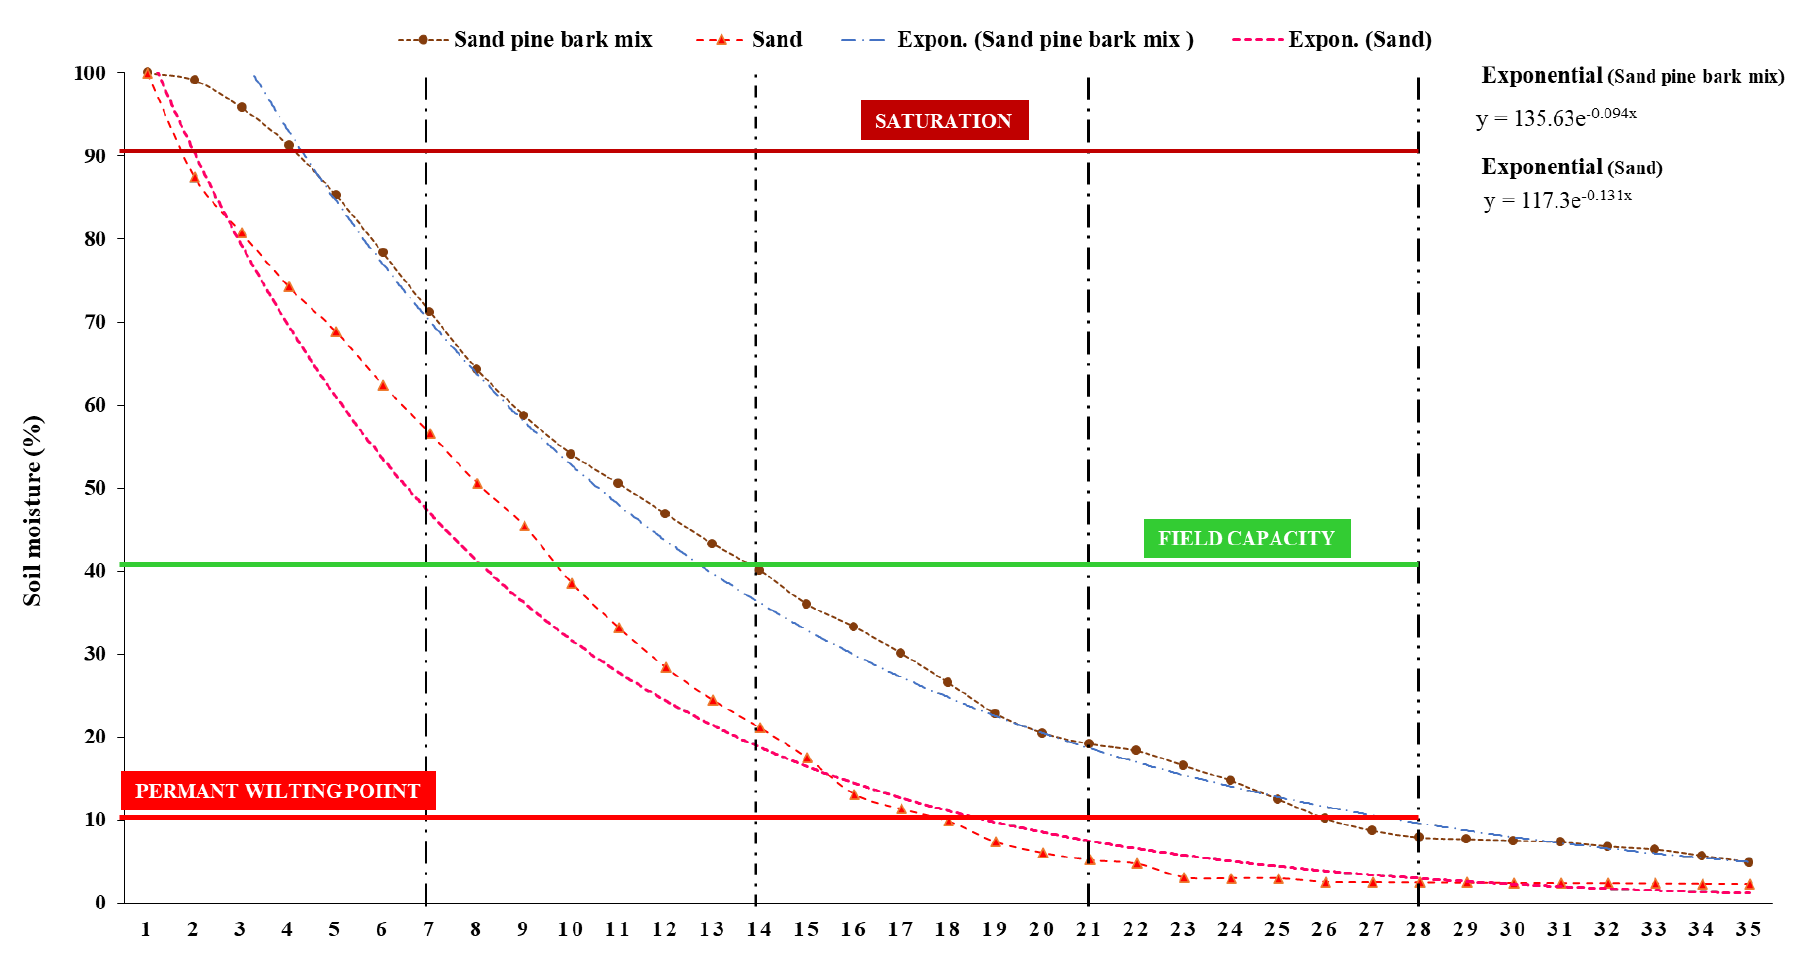
Figure 1. Percentage of soil water content depleted versus time (days) in sand soil, pine bark and sand – pine bark mix.